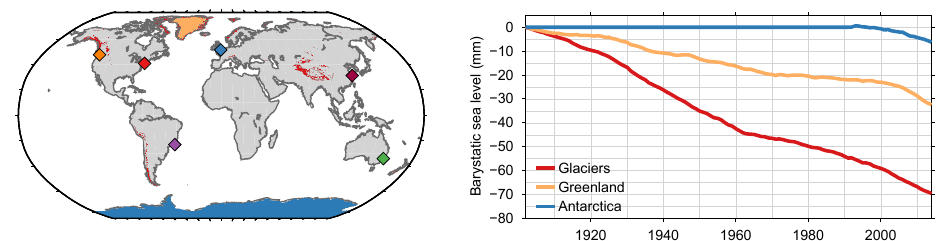
Figure 1. Left: land ice regions considered in this study (red, glaciers; orange, Greenland; blue, Antarctica), with coloured diamonds repre- senting the coastal cities of Fig. 3. Right: global mean sea-level contribution of ice wastage between years 1902 and